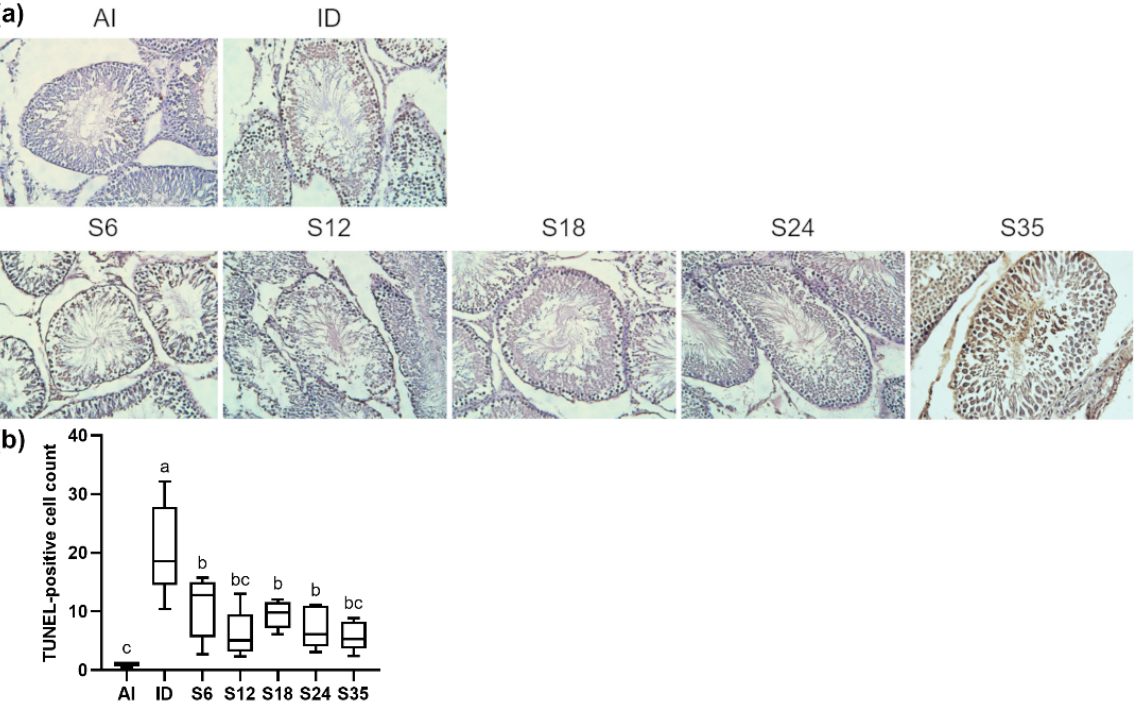
Figure 10. Effects of different doses of iron supplementation on ( a ) TUNEL staining of the testis and ( b ) TUNEL-positive cells in iron-deficient rats. Values are presented as median (interquartile range, IQR). n = 4 per group. Values not sharing the same letters are significantly different at p < 0.05.